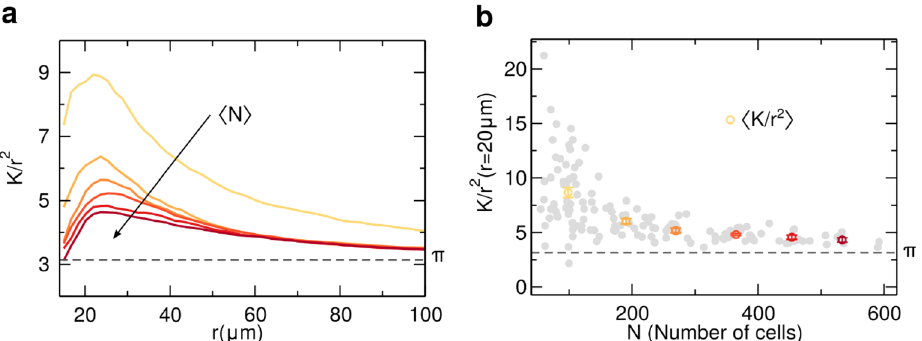
Figure 2. Proliferation and spatial correlations. Ripley’s K-function was used to characterize the distribution of the nuclei in the substrate. To enhance how far the experimental spatial distribution of glioblastoma multiform 2 (GBM) cells is from a random process, we show K / r as a function of the distance r for values larger than 2 15 μm, avoiding imprecisions from a possible superposition of two nuclei. In ( a ) it is shown the average K / r N N for different values of the average number of cells in the substrate . The colors represent , from yellow (cid:31) (cid:30) (cid:31) (cid:30) (low density) to dark red (high density), following the linear spaced bins shown in ( b ). With a low density of 98 ), it was observed that the distribution has a distinct peak and decays slowly N cells in the substrate ( � � = N to π , however, this correlation peak start to decrease as increases during the 24 h of experiment. In ( b ) it (cid:31) (cid:30) 2 is depicted the evolution of the spatial correlation K / r as a function of the number of GBM cells ( N ) for a distance r = 20 μm. Each grey circle is a different measurement. The colored circles (yellow to dark red) are averages from equal spaced bins on N , exhibiting a rapidly monotonic decrease as the number of cells